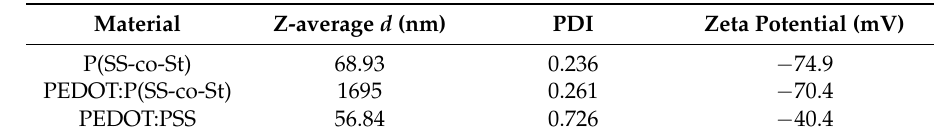
Table 1. Z-average particle diameter, polydispersity index (PDI), and zeta potential for P(SS-co-St), PEDOT:P(SS-co-St), and PEDOT:PSS.